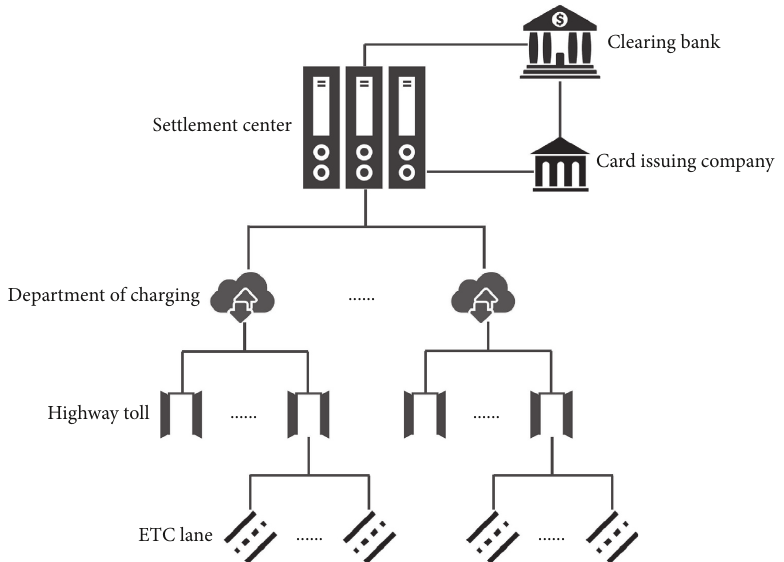
Figure 1: Structure of the ETC